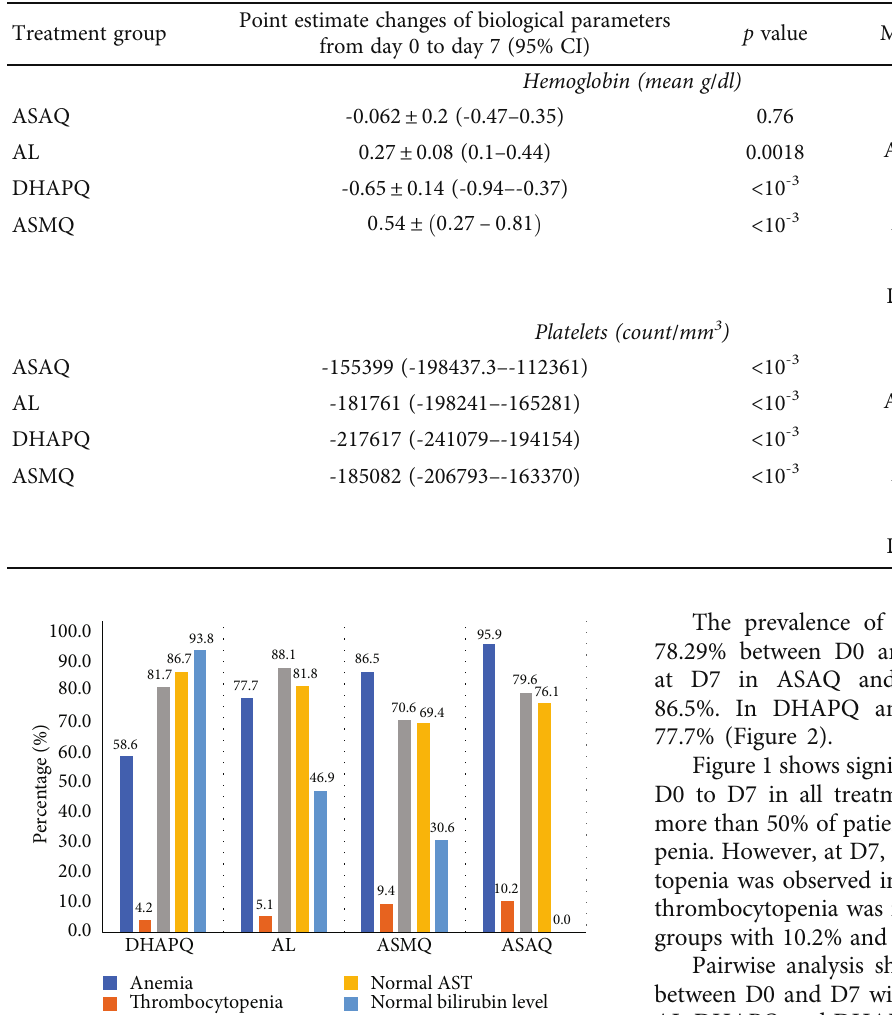
signi fi cant di ff erence ( p = 0 : 76 ). In AL group, mean hemoglo-